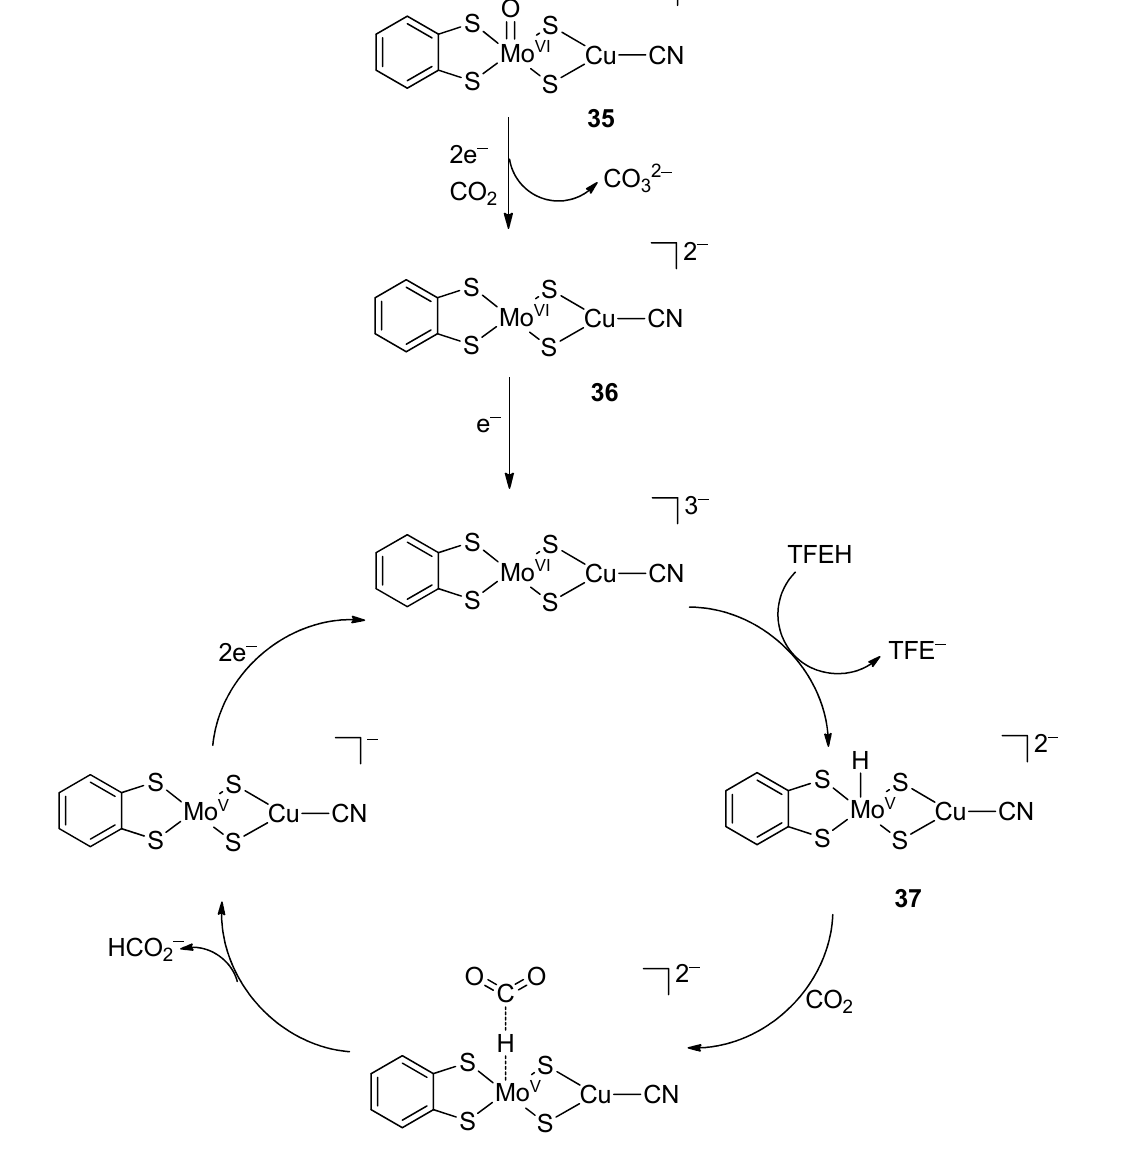
Figure 8. Two model complexes of [MoCu]CODHs.